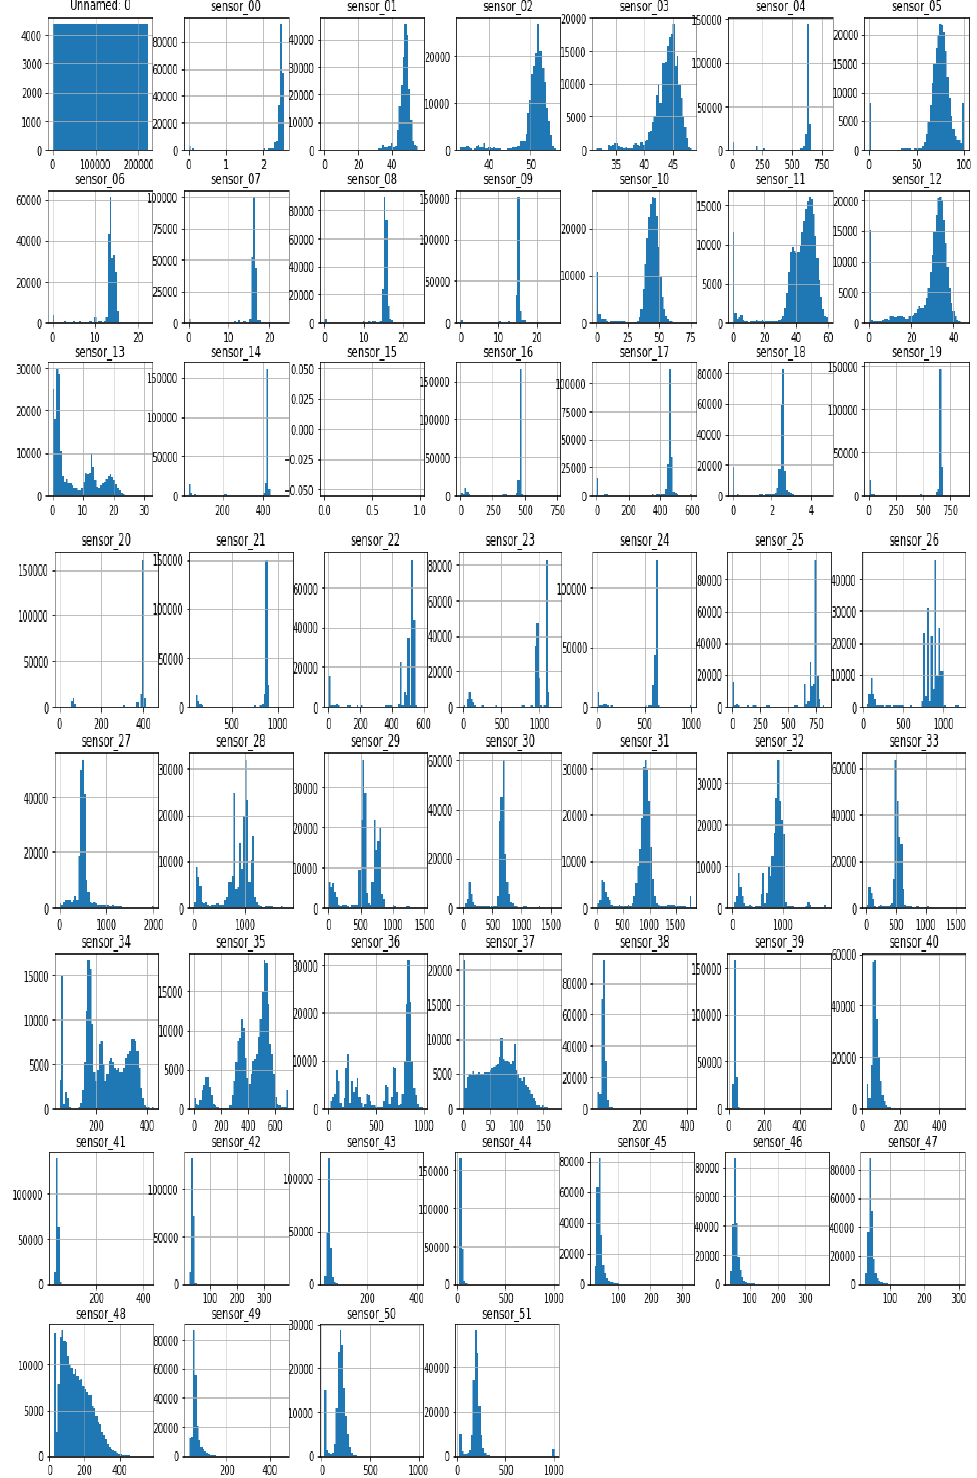
Figure 5. Exploratory data analysis.